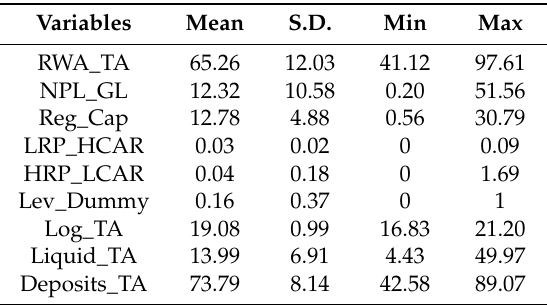
Table 1. Summary statistics.